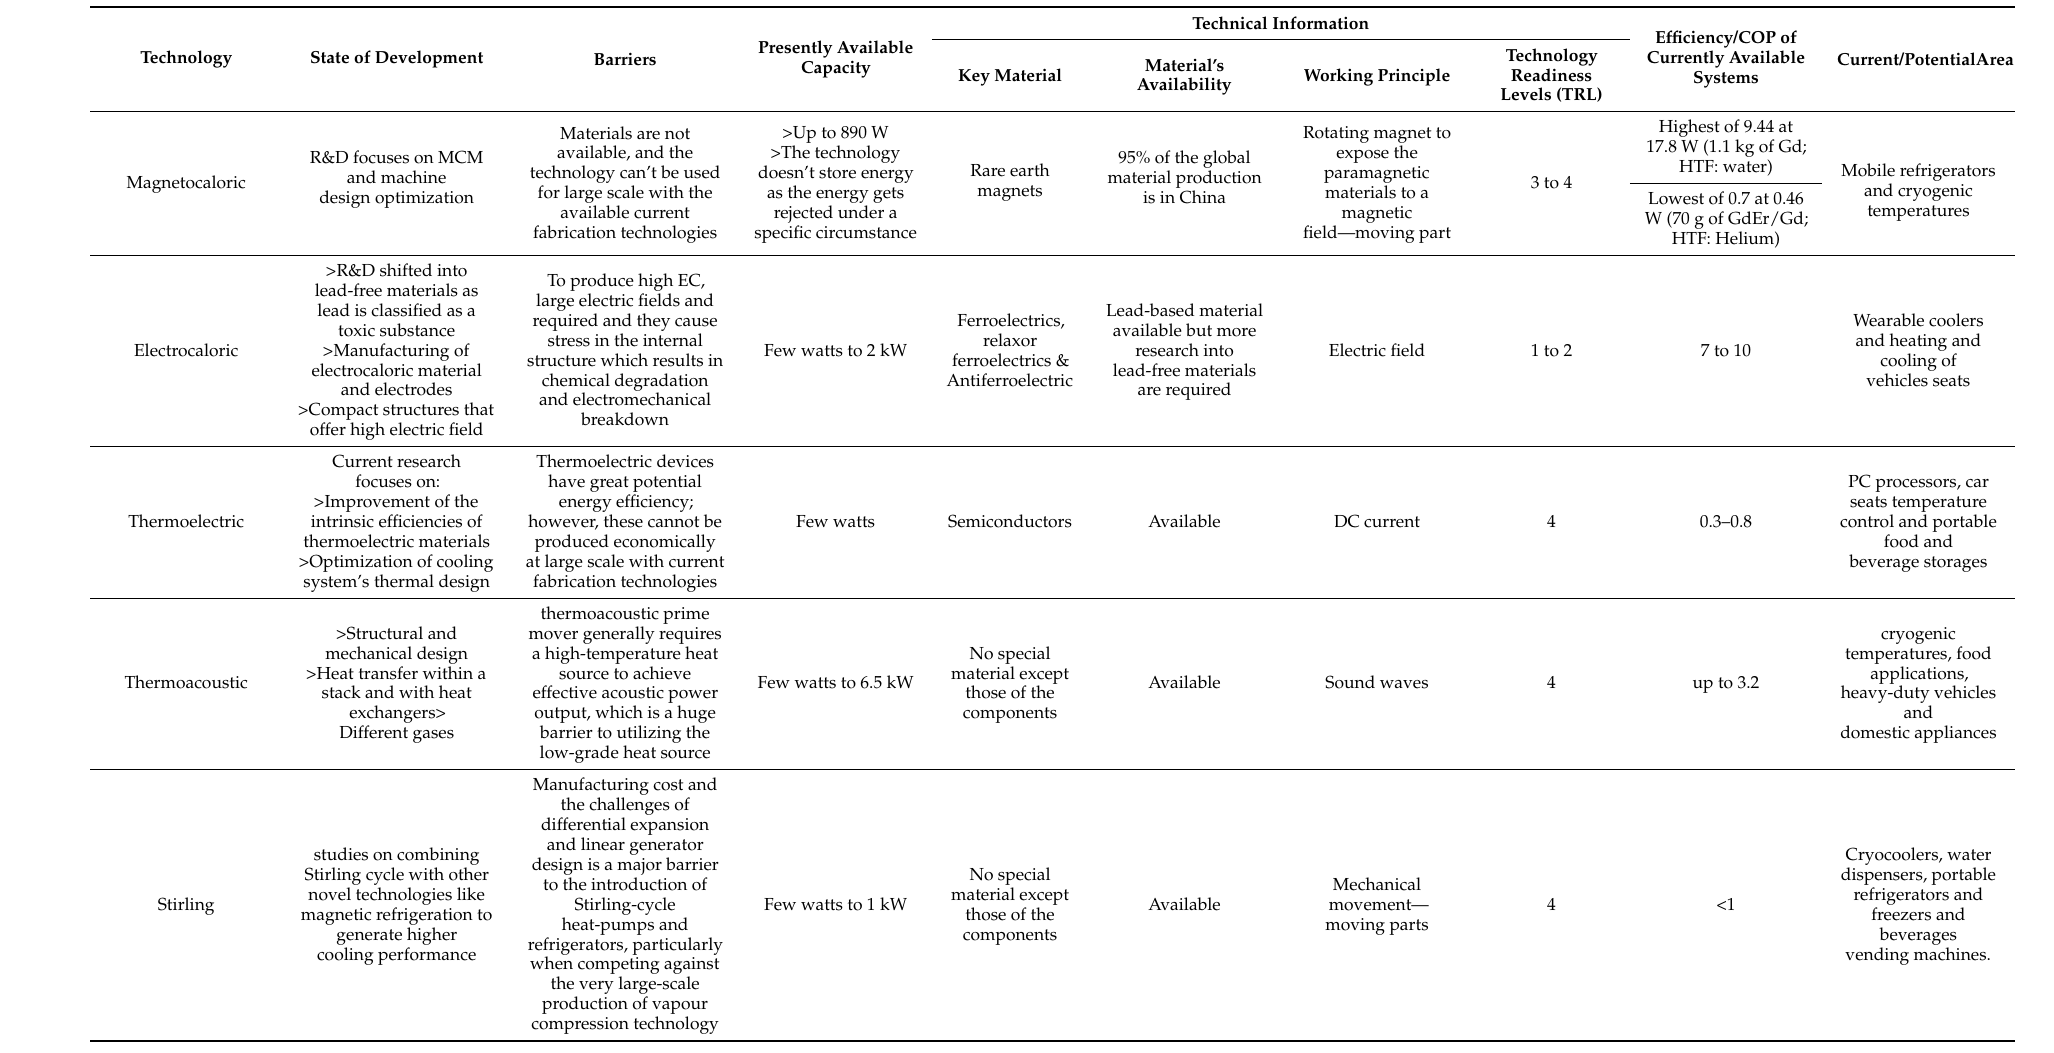
Table 1. Characteristics and applications of emerging refrigeration